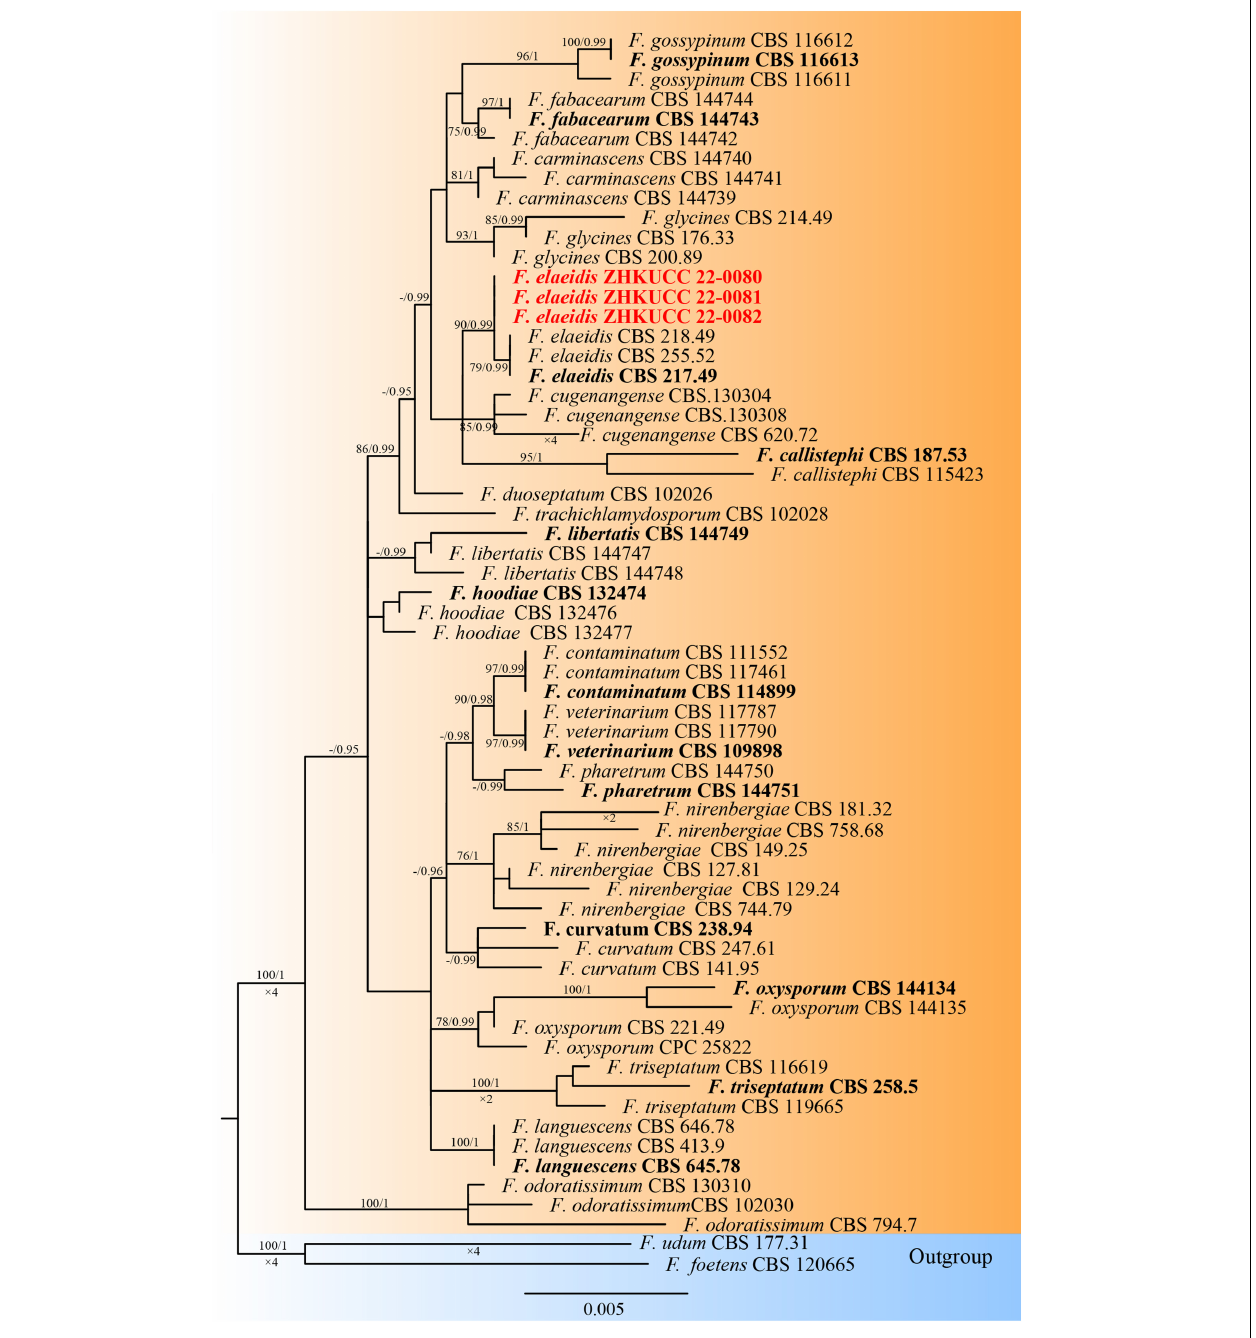
FIGURE 3 | The Best scoring RAxML tree obtained from the combined with rpb2 , tef1- α , and β -tubulin sequence alignment of the Fusarium oxysporum complex. The ML bootstrap support values ≥ 75% and BYPP higher than 0.90 are indicated at the nodes and branches. The scale bar indicates 0.005 changes per site. Ex–type/ex–epitype strains are in bold. New isolates recovered in this study are in